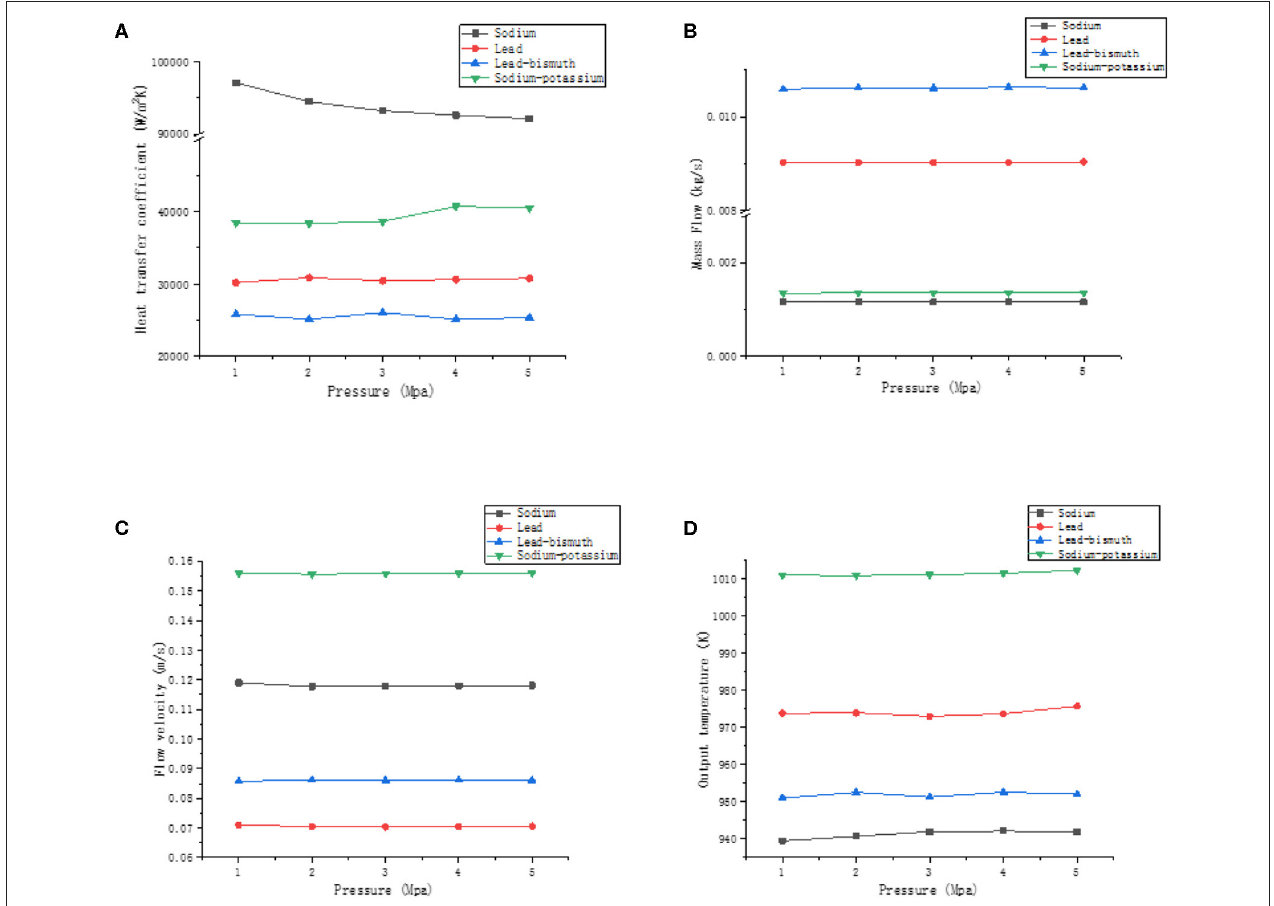
FIGURE 8 | The effect of pressure. (A) Effect of pressure on the heat transfer coefficient, (B) effect of pressure on mass flow, (C) effect of pressure on velocity, and (D) effect of pressure on outlet temperature.